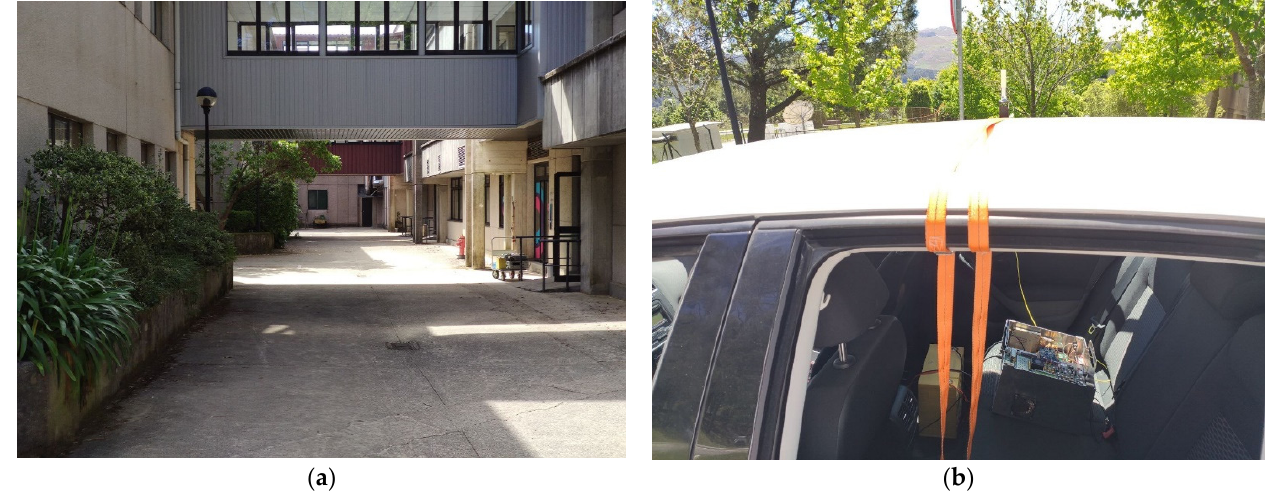
Figure 9. ( a ) Alley; ( b ) receiver mounted in the car for the tests in the alley.